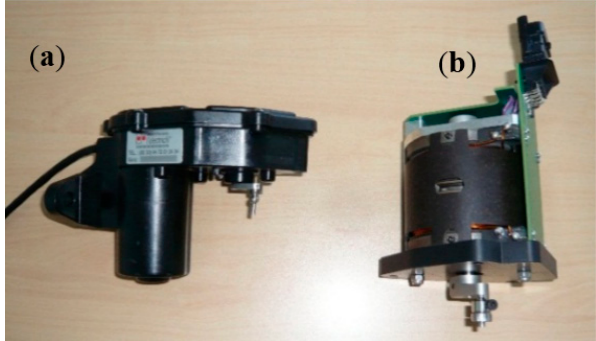
Figure 2. Indirect and direct drive actuator prototypes: ( a ), the indirect drive actuator, ( b ) the direct drive actuator. As presented in [7], both actuators are optimized with the same requirements in order to compare their energy consumptions.